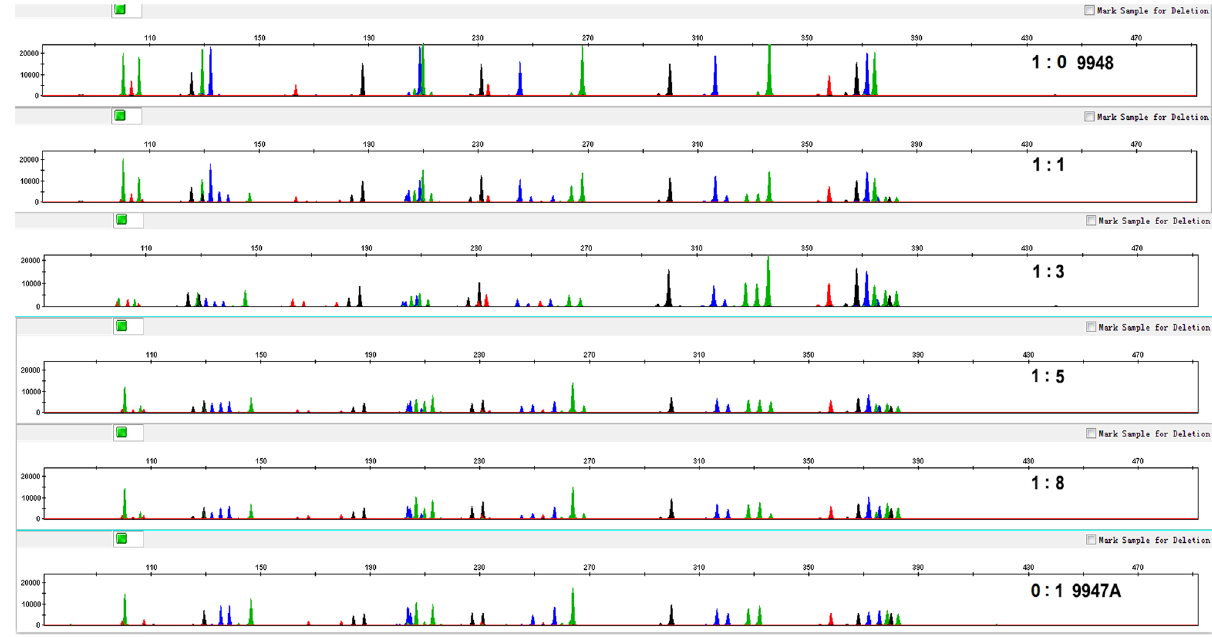
Figure 4. Representative electropherograms of a 1:0, 1:1, 1:3, 1:5, 1:8, and 0:1 mixture of control DNA 9948 and 9947A with a total of 1 ng of